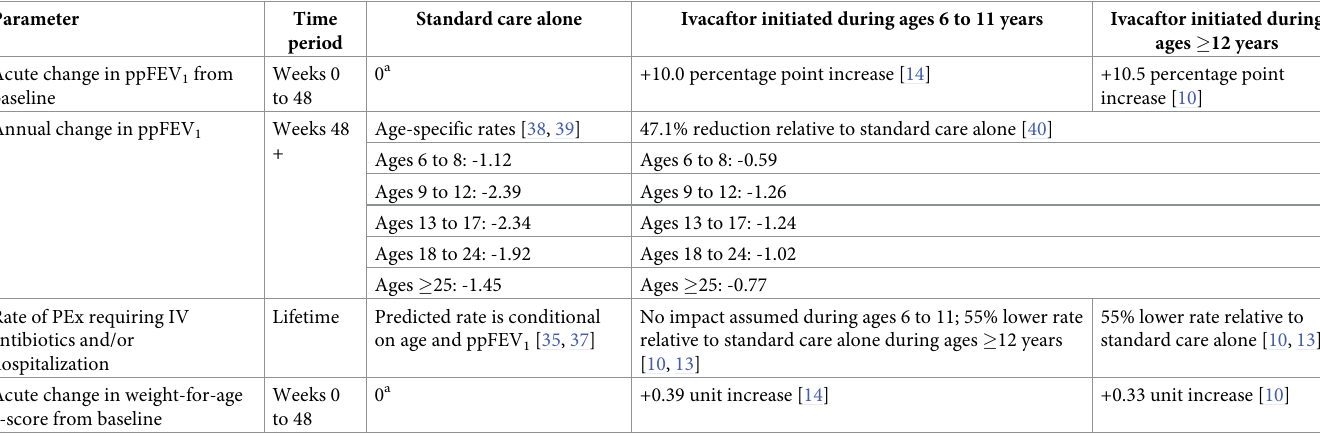
Table 1. Model inputs for disease progression and ivacaftor treatment efficacy [10, 13, 14, 35, 37–40].